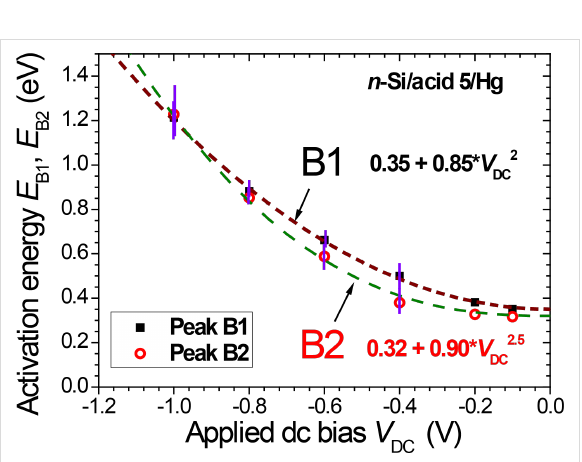
Figure 5: Bias dependence of dipolar relaxation activation energies, E B1 (squares) and E B2 (circles). The lines are power-law functions with forced exponent values: E B1 (eV) = 0.35 + 0.85 | V DC | 2 ; E B2 (eV) = 0.32 + 0.90 | V DC | 2.5